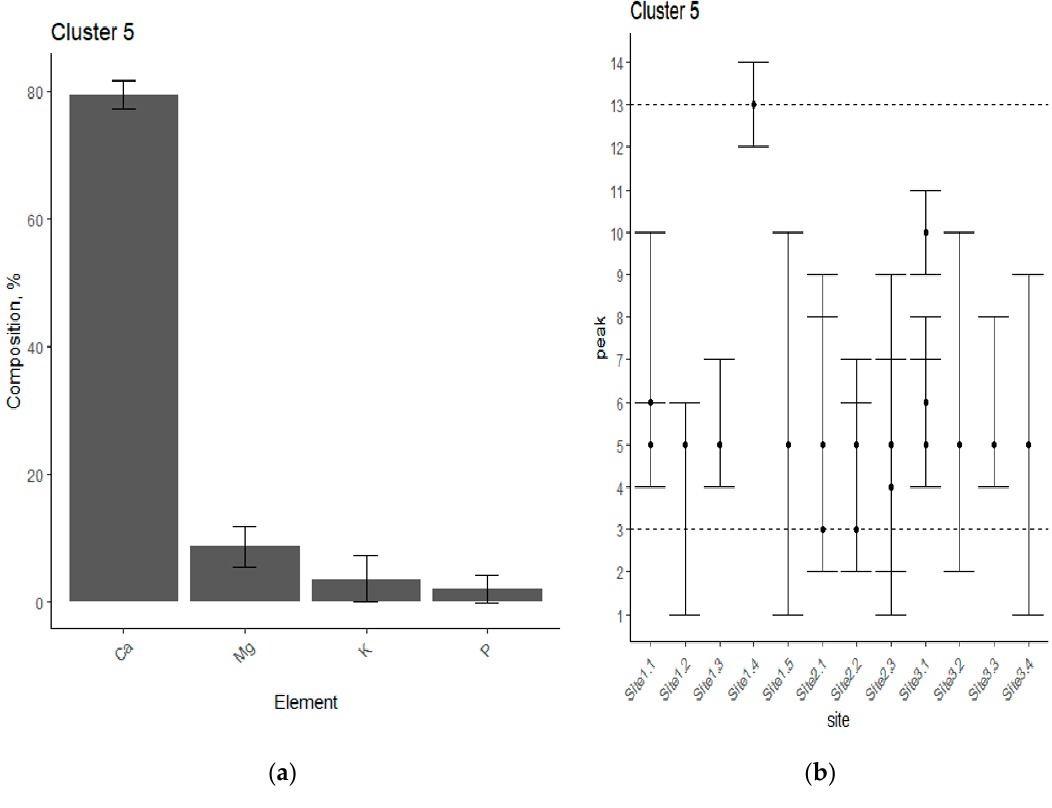
Figure 8. ( a ) Average chemical composition and standard deviation of the components in cluster 5; ( b ) extraction peak location and their windows of extraction for cluster 5 components. Geosciences 2020 , X , x FOR PEER REVIEW